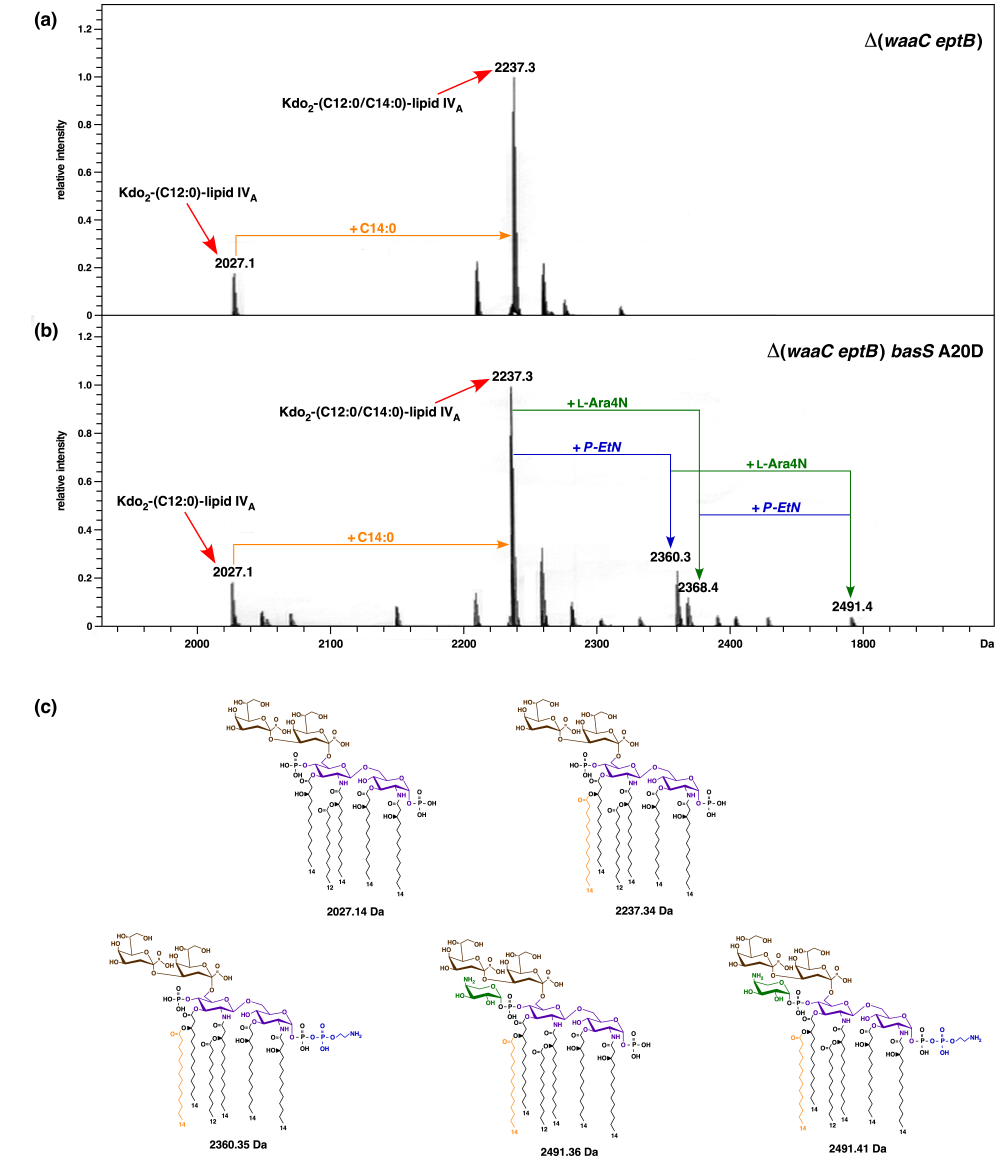
Figure 9. basS A20D suppressor mutation of the Ca ++ sensitivity of ∆ ( waaC eptB ) induces the incorporation of lipid A modification by P-EtN and L-Ara4N, thereby compensating for the absence of P-EtN on the second Kdo due to the lack of EptB phosphoethanolamine transferase, even under conditions where lipid A modifications are not incorporated. ( a ) Mass spectra of LPS obtained from the ∆ ( waaC eptB ) strain grown at 37 ◦ C in LB medium. ( b ) Mass spectra of LPS obtained from the isogenic ∆ ( waaC eptB ) basS A20D strain grown at 37 ◦ C in LB medium. Charge-deconvoluted ESI FT–ICR mass spectra in negative ion mode are presented. The mass numbers refer to monoisotopic peaks with the proposed composition. Incorporation of P-EtN and L-Ara4N in the lipid A is indicated when basS A20D suppressor mutation is present. ( c ) Schematic drawing of the predicted chemical structures of various lipid A derivatives, with or without the modifications by P-EtN and L-Ara4N identified in panels a and b, with predicted mass numbers, are